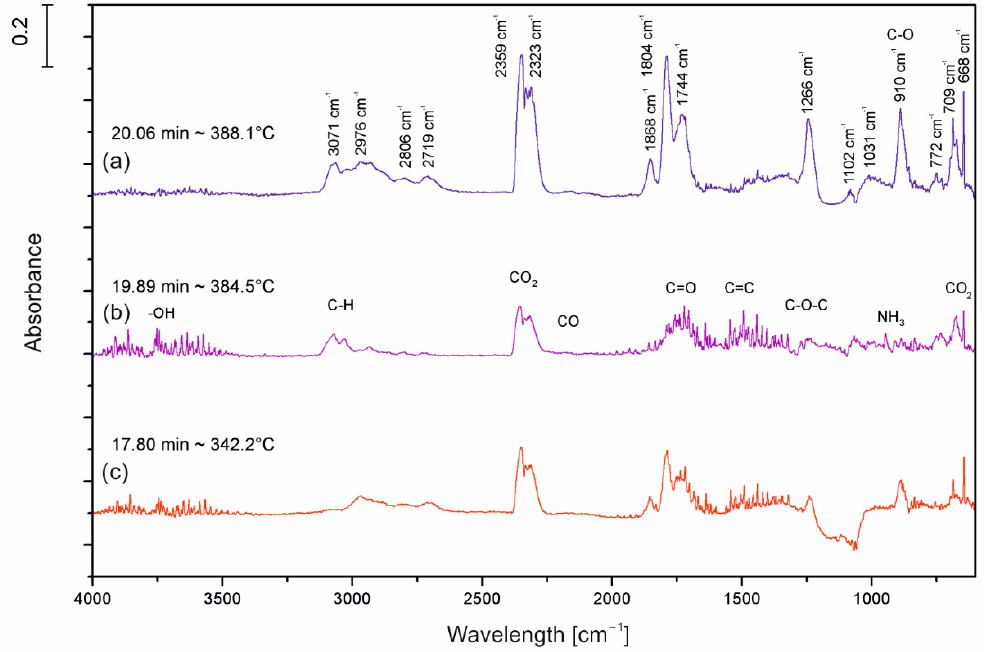
Figure 11. FT-IR spectra of volatilized products released at the maximum evolution rate from UP ( a ), UP/30APP ( b ) and UP/30LHP ( c ).